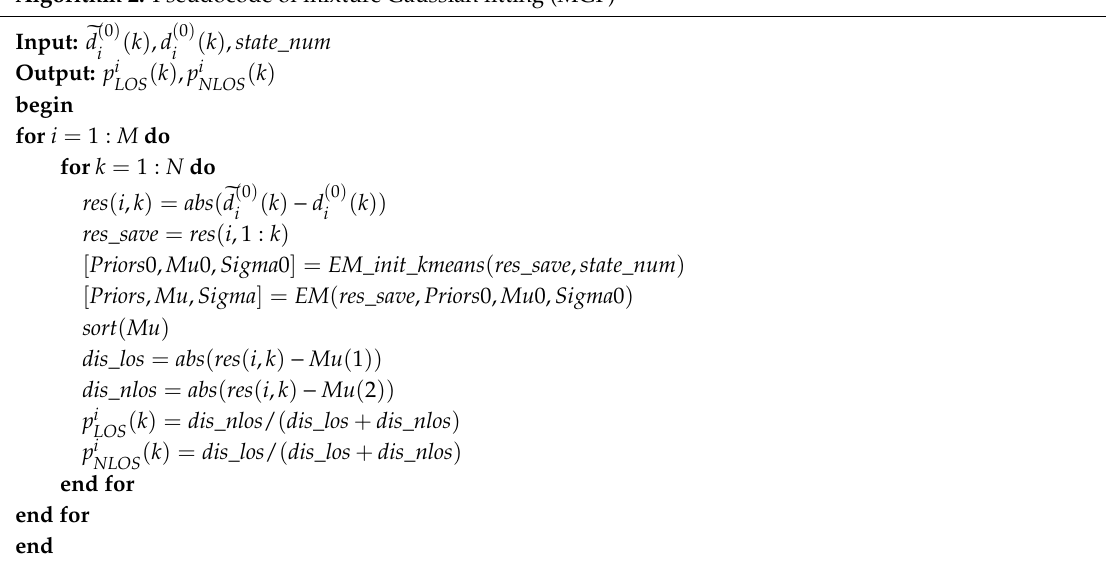
Algorithm 2. Pseudocode of mixture Gaussian fitting (MGF)